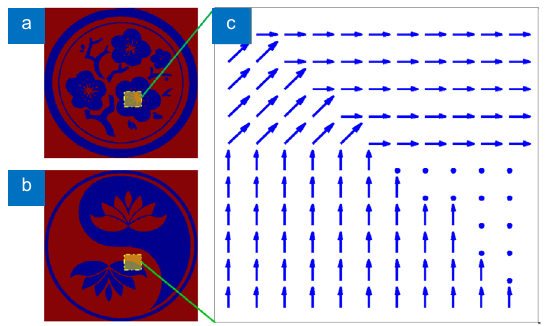
Fig. 3 | Vector composition diagram of binary images. ( a , b ) Binary images with pixel numbers 1024  1024 adopted in the de- sign. ( c ) Selected vector synthesis diagram corresponding to the yellow region in (a) and (b). The dots, horizontal, vertical and slant arrows represent (0, 0), (1, 0), (0, 1) and (1, 1),